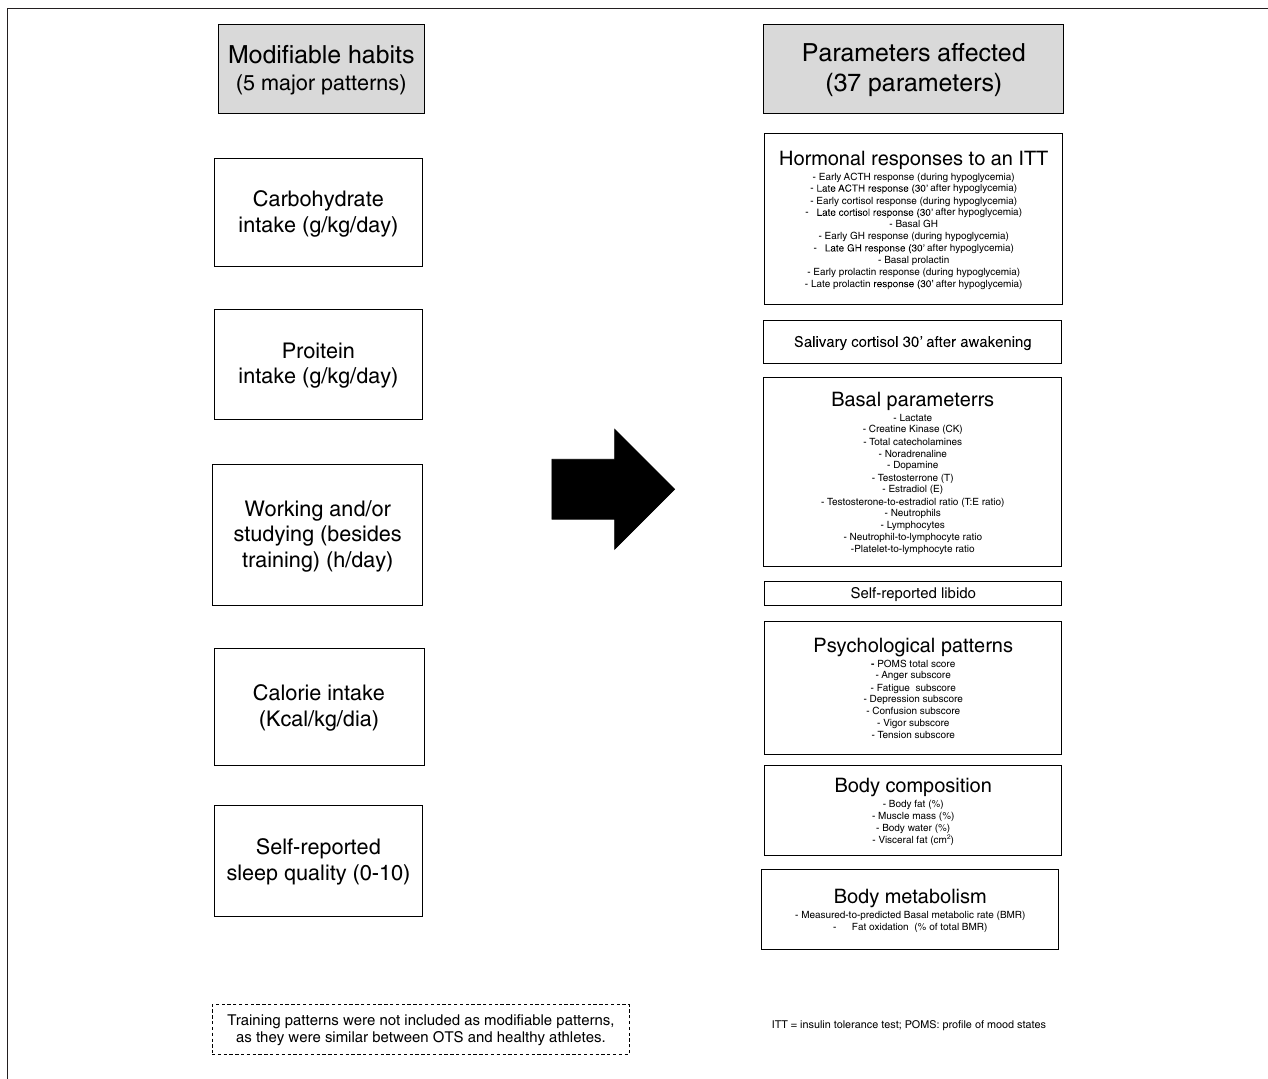
FIGURE 1 | Non-similar modifiable patterns and parameters included in the present analysis.